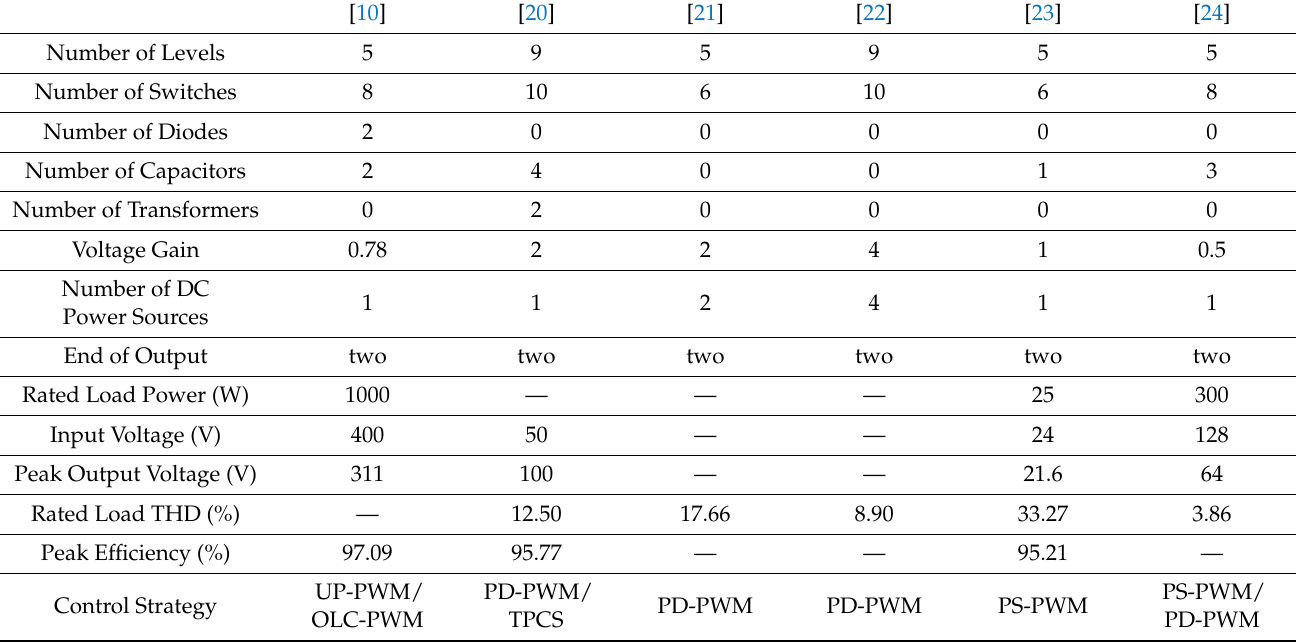
Table 2. Comparison of the recent papers presented for the voltage-fed single-phase